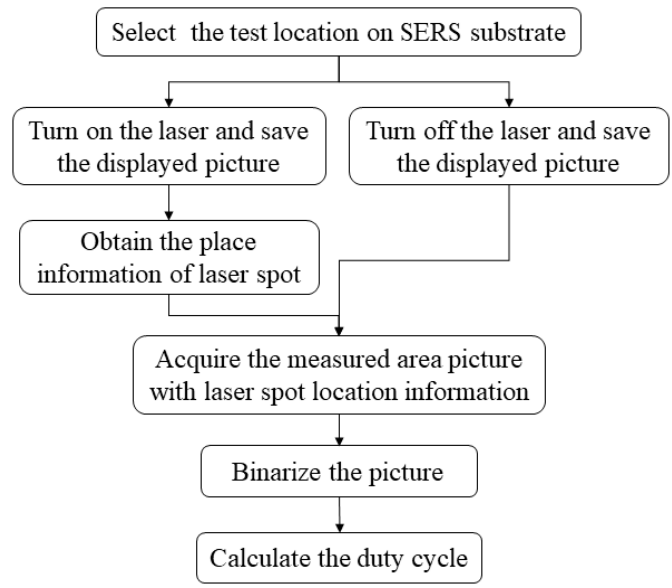
Figure 4. Calculation flow chart of duty cycles.